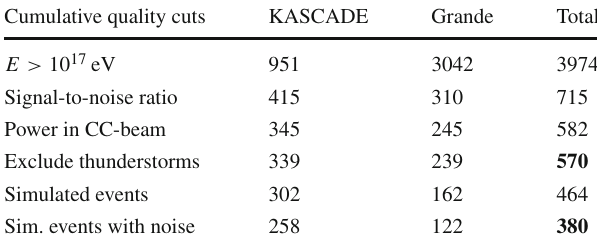
Fig. 8 Impact point of the shower axis (core) of the events passing the quality cuts described in the text. In addition to the KASCADE array (Fig. 3) also the detector locations of the larger KASCADE-Grande array are shown Table 3 Statistics of LOPES events used in this paper. The two sub- sets of LOPES events triggered and well reconstructed by KASCADE and KASCADE-Grande, respectively, overlap by a few events which is why the total number of events is less than the sum. For those measured events remaining after all quality cuts, also the statistics of correspond- ing showers simulated by CoREAS are shown that pass all quality cuts for both cases of a proton and iron nucleus as primary